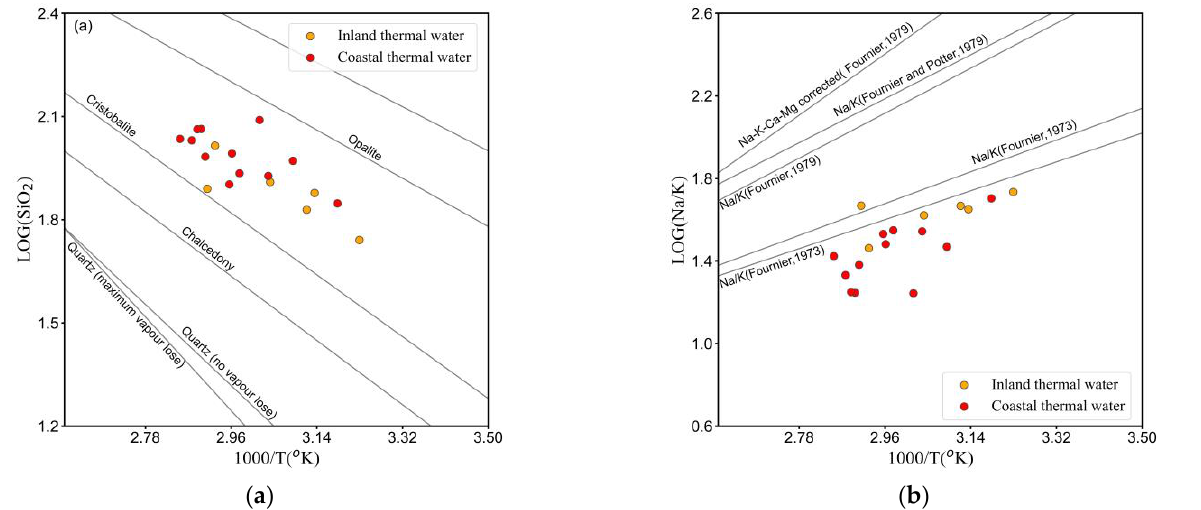
Figure 6. Plots of SiO 2 ( a ), Na/K ( b ), and 1000/T for geothermal water in southeastern China.